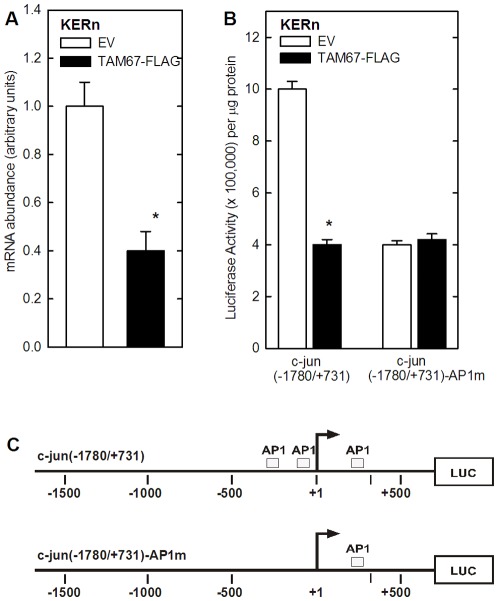
TAM67 suppresses c-jun promoter activity.
A TAM67 reduces c-jun mRNA. Keratinocytes were infected with empty (EV) or TAM67-FLAG encoding adenovirus (10 MOI) and after 24 h mRNA was prepared and c-jun mRNA level was measured by quantitative PCR. B TAM67 suppresses c-jun promoter activity. Keratinocytes were transfected with 1 µg of the indicated c-jun promoter luciferase reporter construct and 1 µg of pcDNA3 (EV) or pcDNA3-TAM67-FLAG (TAM67-FLAG). After 24 h the cells were harvested and assayed for luciferase activity. The values in both plots are mean + SD and the asterisks indicate a significant reduction (p<0.005, n = 3). C Map of c-jun promoter region. The promoter constructs encode nucleotides −1780 to +731 with the transcription start site at +1. c-jun(−1780/+731) is the wild-type intact promoter and c-jun(−1780/+731)-AP1m is a construct in which the critical AP1 sites are eliminated by mutation [48]. LUC indicates the luciferase gene. The numbers are given in nucleotides.